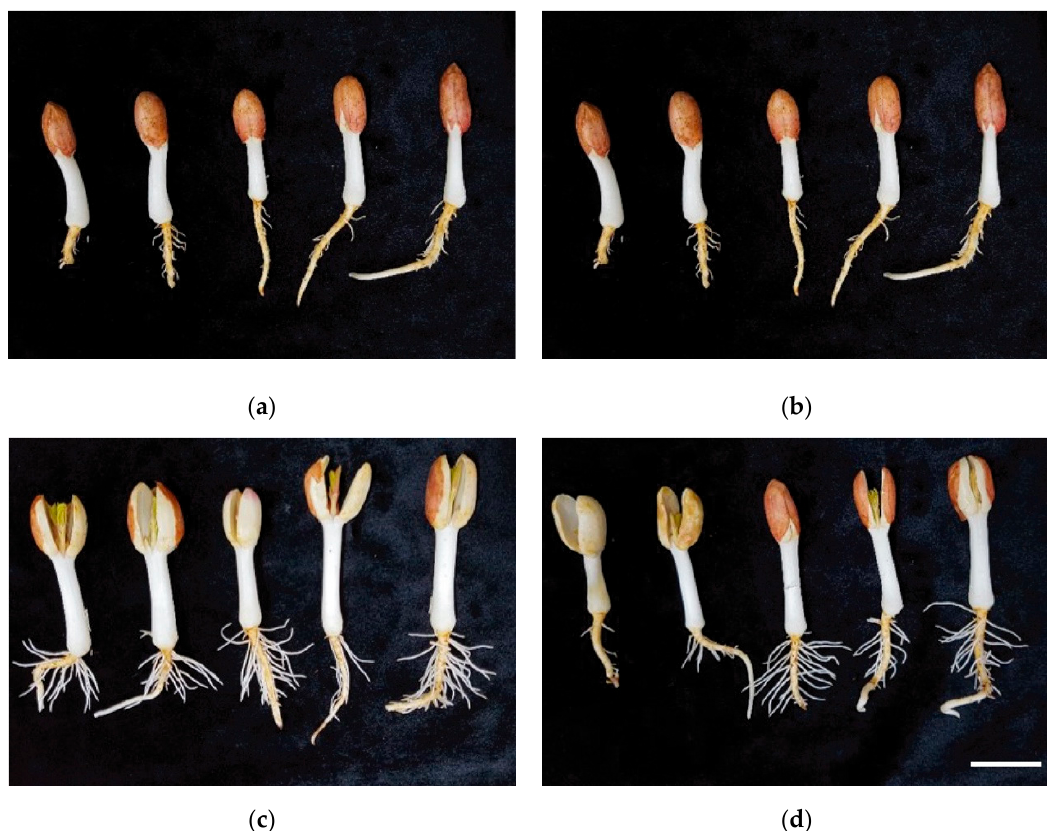
Figure 5. Effect of the fermentation period on the phenotype of the germinated seedling. ( a ): (unfermented oak tree sawdust); ( b ): (30-day fermented oak tree sawdust); ( c ): (45-day fermented oak tree sawdust); ( d ): (60-day fermented oak tree sawdust). Scale bar = 2 cm.